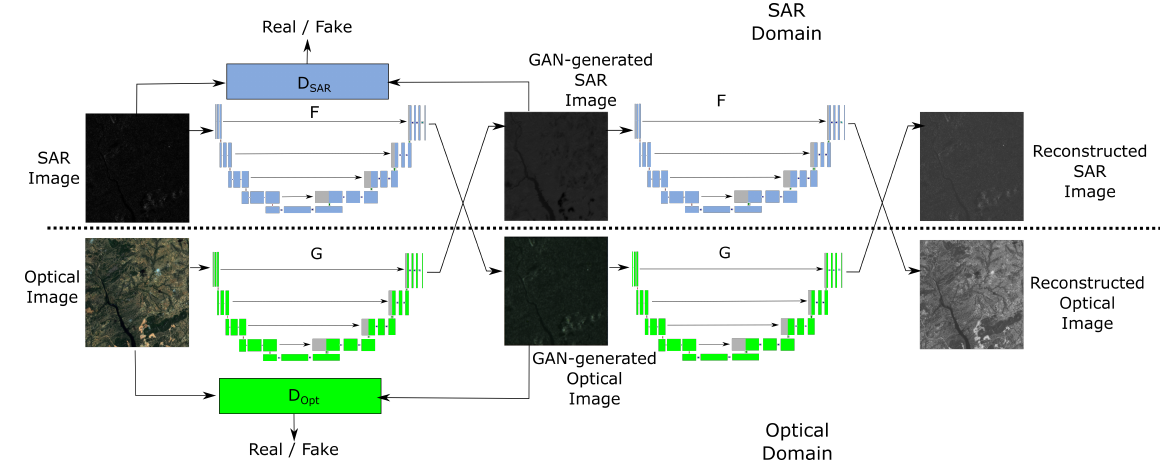
Figure 4. GAN-based image-to-image